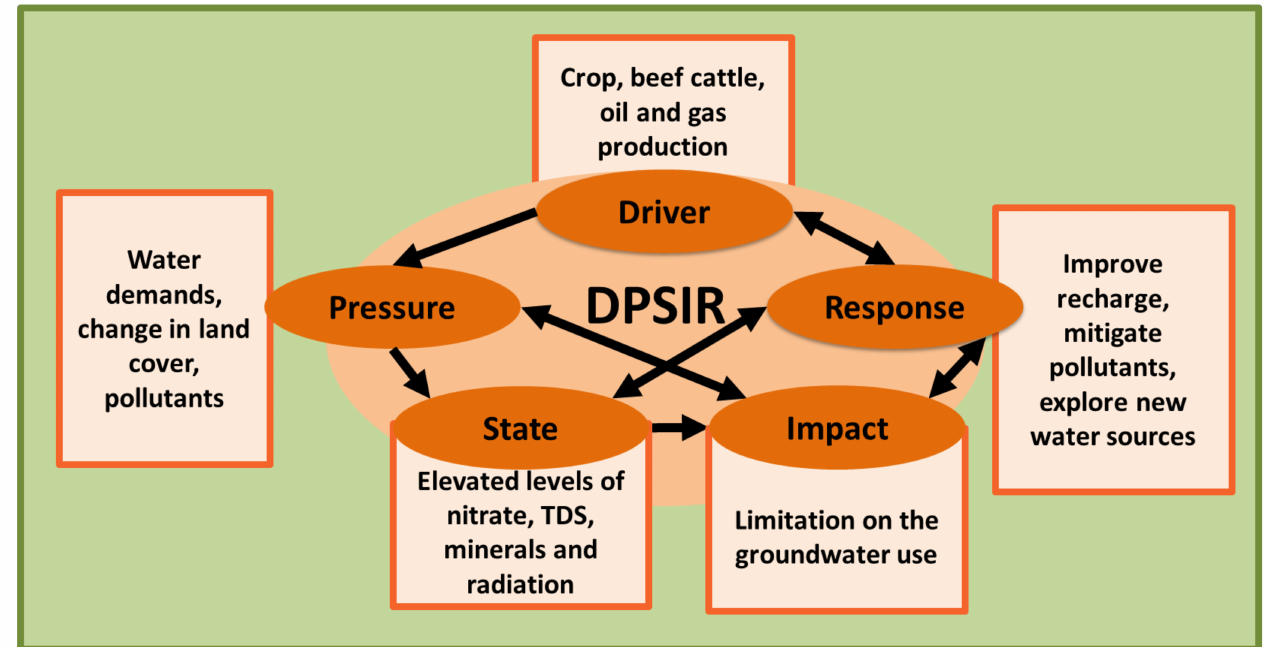
Figure 3. Causal chains and loops in case study